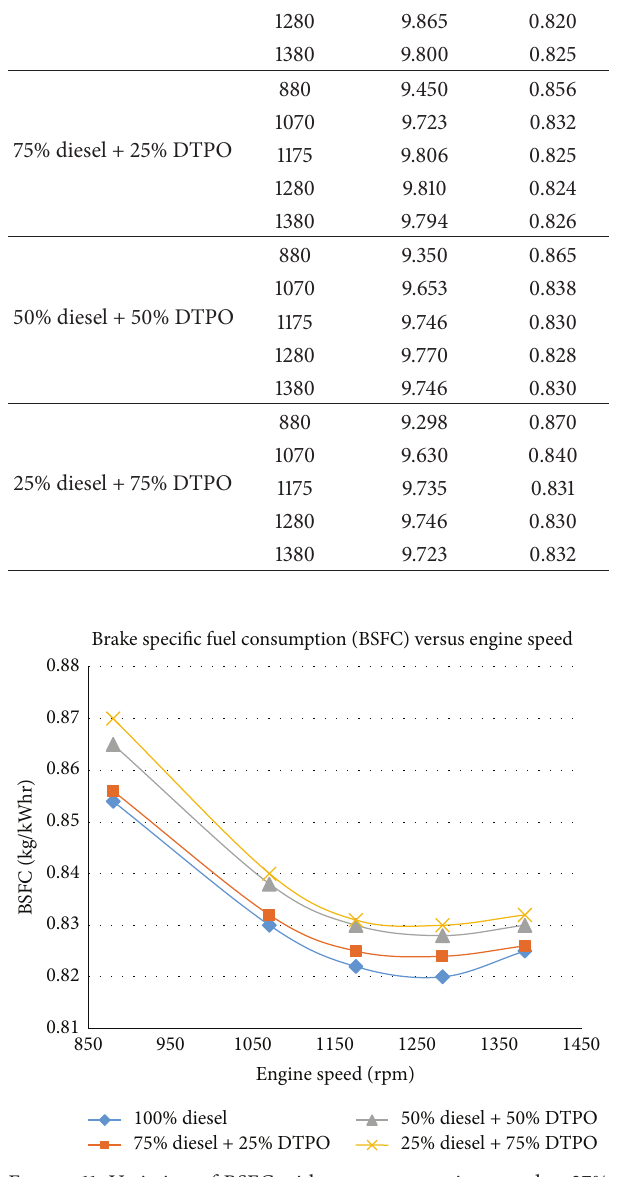
Figure 11: Variation of BSFC with respect to engine speed at 27% part